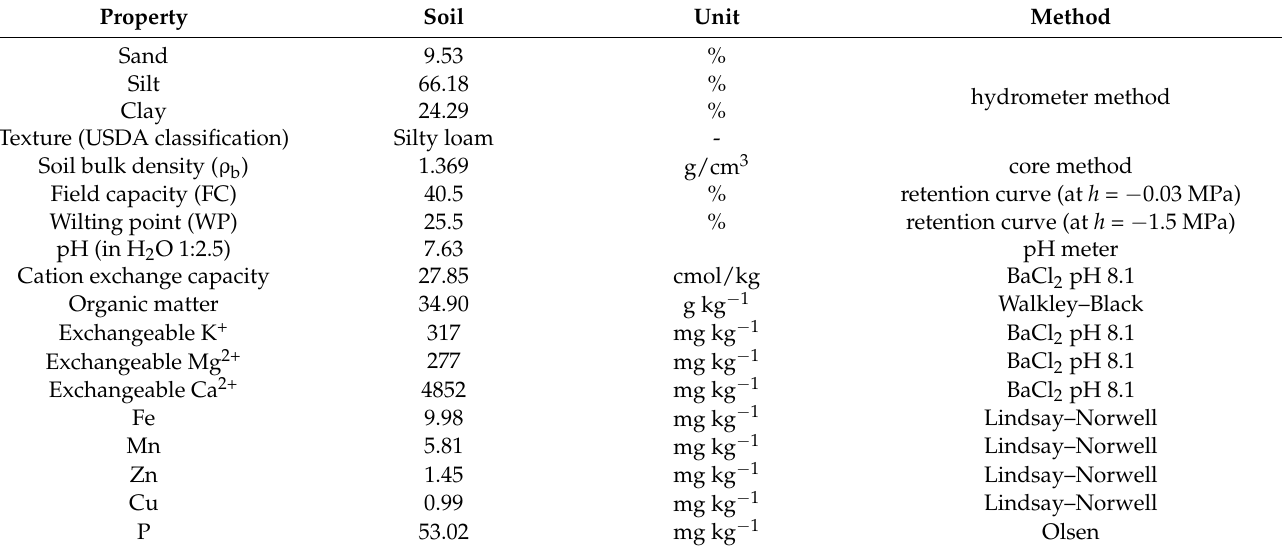
Table 1. Main physicochemical properties of the investigated